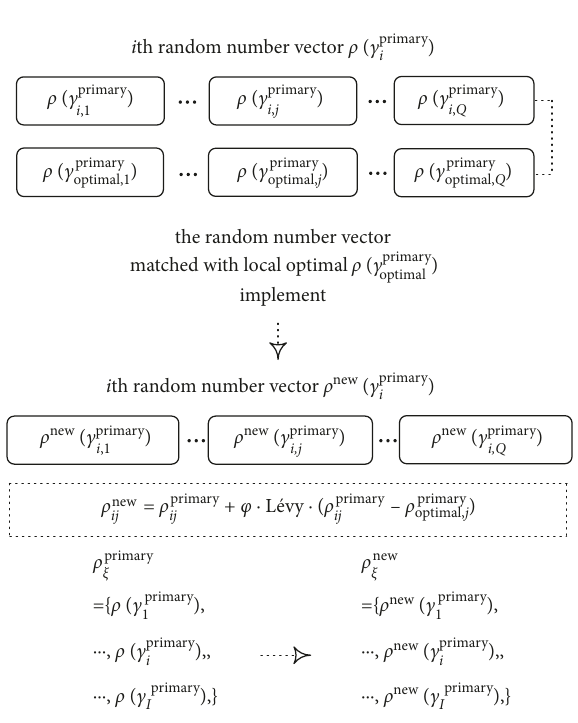
Figure 8: New random number vector group.